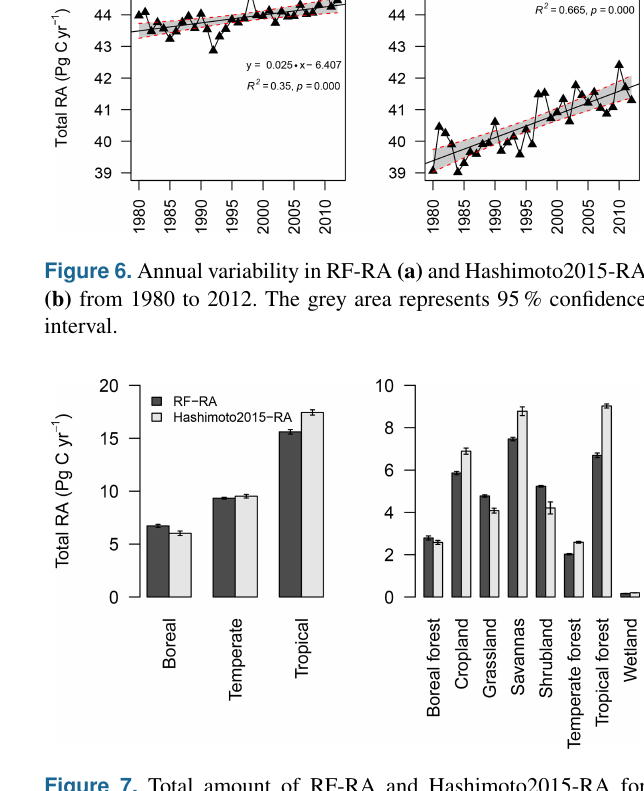
Figure 7. Total amount of RF-RA and Hashimoto2015-RA for three climate zones and eight biomes during 1980–2012. Three cli- mate zones defined as boreal, temperature and tropical regions ac- cording to Peel et al. (2007), while eight biomes include boreal forest, cropland, grassland, savannas, shrubland, temperate forest, tropical forest and wetland. The error bars indicated standard devi-